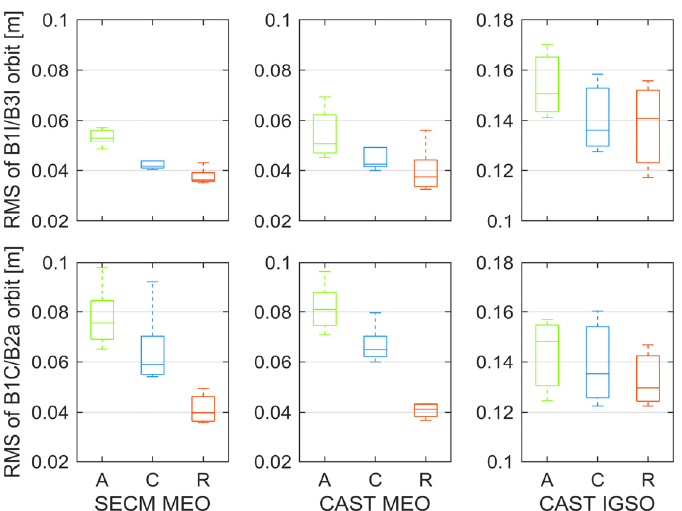
Figure 5. Box plot of RMSs of ISC orbits based on B1I/B3I and B1C/B2a in along-track, cross-track, and radial directions for SECM MEO, CAST MEO, and CAST IGSO satellites, respectively.